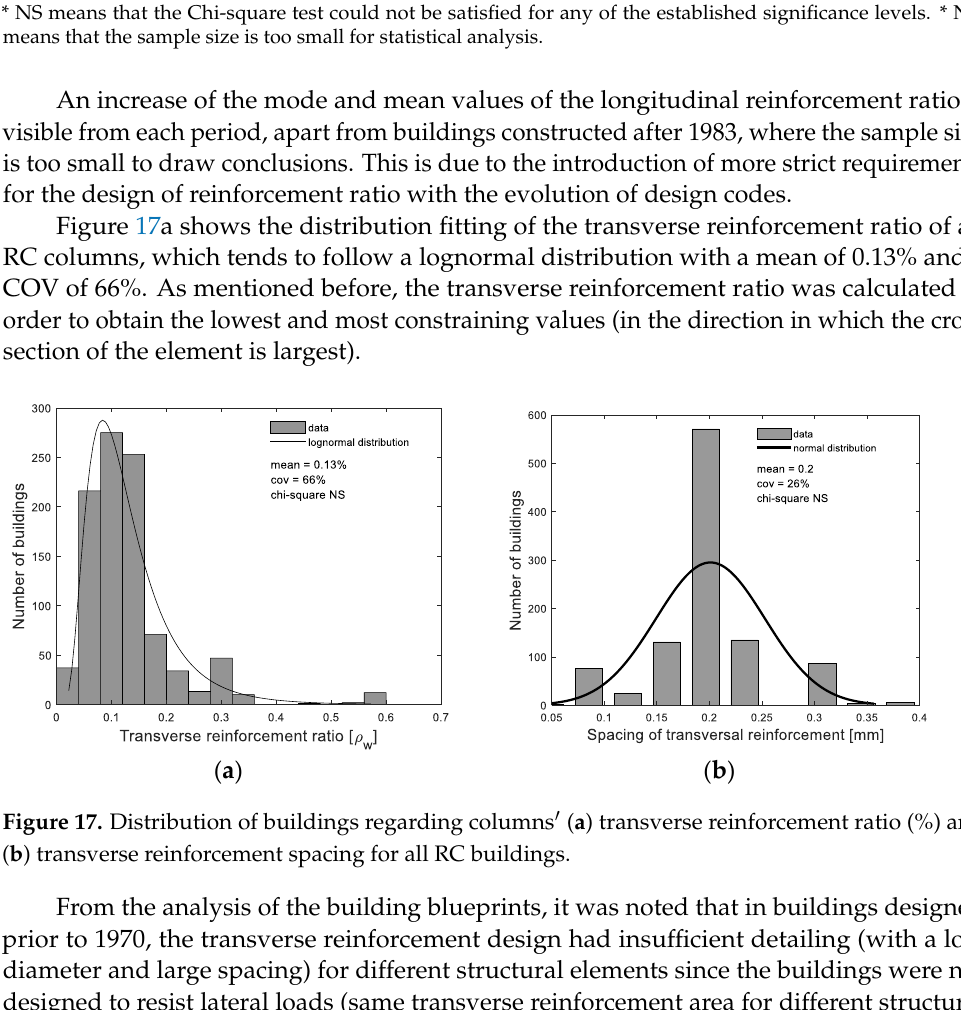
Table 11. Probabilistic distribution of RC columns′ transverse reinforcement ratio (ρ w ) in function of the lateral load resisting system (LLRS) and period of construction.